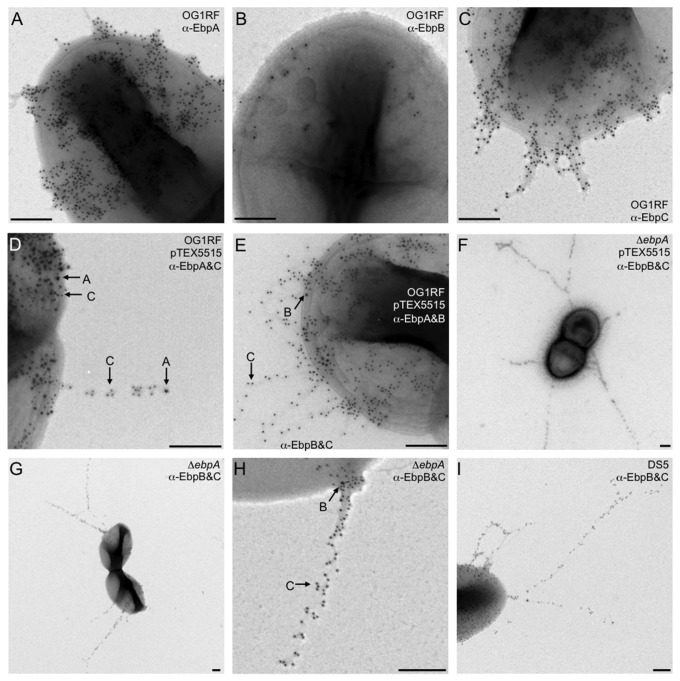
IEM analysis of pilus production by E. faecalis OG1RF, ebpA deletion mutant and strain DS5.(A) WT OG1RF stained with anti-EbpA (12 nm); (B) WT OG1RF stained with anti-EbpB (12 nm); (C) WT OG1RF stained with anti-EbpC (12 nm); (D) OG1RF (pTEX5515) stained with anti-EbpA (18 nm) and anti-EbpC (12 nm); (E) OG1RF (pTEX5515) stained with anti-EbpB (18 nm) and anti-EbpC (12 nm); (F) OG1RFΔebpA (pTEX5515) stained with anti-EbpB (18 nm) and anti-EbpC (12 nm); (G) OG1RFΔebpA stained with anti-EbpB (18 nm) and anti-EbpC (12nm); (H) OG1RFΔebpA stained with anti-EbpB (18 nm) and anti-EbpC (12nm); (I) E. faecalis DS5 stained with anti-EbpB (18 nm) and anti-EbpC (12 nm). Bacteria were grown in TSBG to exponential phase. In panels with antibody double labeling, examples of each stained pilin are shown by arrows. Scale bars 200 nm.